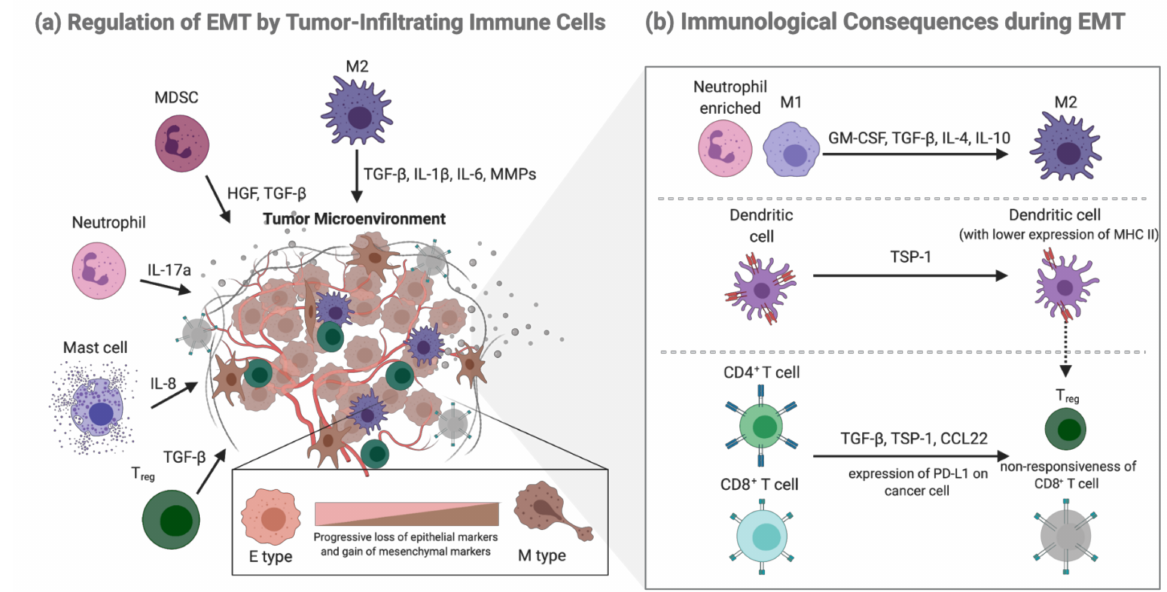
Figure 1. ( a ) Several immune cell types, including macrophage, MDSC, neutrophil, mast, and Treg cells, can secrete correspondent inducing factors to activate downstream signaling pathways and promote EMT. ( b ) As EMT progresses, the neutrophil-enriched TME switches to a place occupied by M2 macrophages; Dendritic cells are impaired and show lower expression of MHC II; Effective CD4+ T cells transit to immunosuppressive Treg cells, and CD8+ T cells become dull in terms of with their cytotoxic ability. Created with BioRender.com (accessed on 12 July